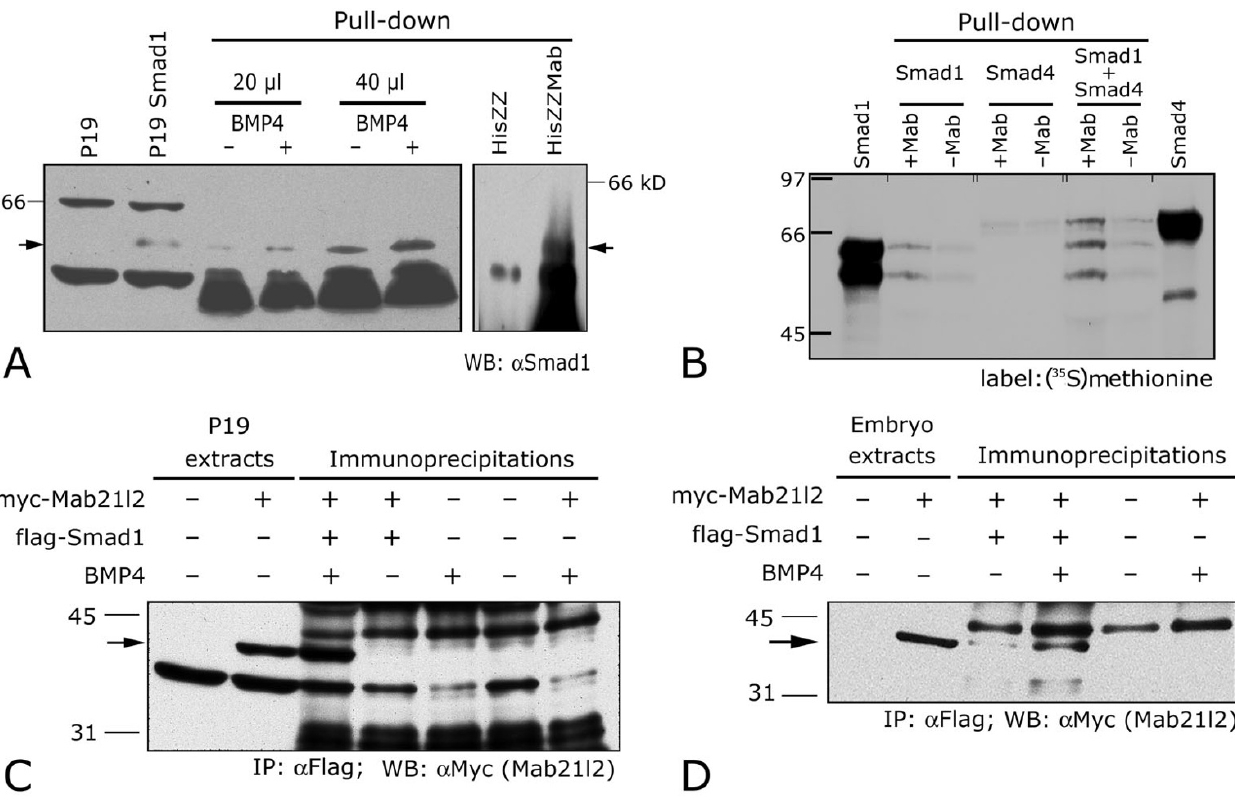
Figure 5 Mab21l2 interacts with Smad1 in vitro and in vivo. (A) Lanes 1, 2: immunoblotting of total lysates from P19 cells, mock- and Smad1 -transfected, respectively. P19 cells do not express detectable levels of endogenous SMAD1. Lanes 3–8: Affinity chromatography (pull-down) experiment. High-stringency eluates from untransfected P19 were separated by SDS-PAGE and transfered onto nitrocellulose filters. The blots were immunolabeled using an anti-SMAD1 antibody. Lanes 3–6: the in vitro interaction is not strictly dependent on activation of BMP signaling: the pull-down experiment was performed with 20 µ l (3, 4) and 40 µ l of P19 cell lysates (5, 6). Lysates came from P19 cells treated (4, 6) or untreated (3, 5) with BMP4. Lanes 7, 8: an His- ZZ-MAB21L2 protein (HisMab) synthesized in E. coli (lane 8) was coupled to a sepharose-Ig resin and incubated with cell lysates of P19 cells treated with BMP4. As a negative control, an in-vitro synthesized His-ZZ incubated with the same P19 lysates fails to pull down a 53 kD band. Arrows: SMAD1 (53 kD). (B) direct interaction between SMAD1 and MAB21L2; no direct interaction between SMAD4 and MAB21L2. An His-ZZ-MAB21L2 protein (+Mab) synthesized in E. coli (lane 2) was cou- pled to a sepharose-Ig resin and incubated with in vitro -translated SMAD1 (lanes 2), SMAD4 (lanes 4), and SMAD1 + SMAD4 (lanes 6). Negative controls were represented by His-ZZ-coupled resins (-Mab) incubated with the same in vitro -synthesized proteins (lanes 3, 5, 7). Lanes 1 and 8 contain in vitro -synthesized SMAD1 and SMAD4, respectively. (C) BMP4-dependent in vivo co-immunoprecipitation of flag-SMAD1 and myc-MAB21L2 in P19 cells. Cells were mock-transfected, transfected with flag- SMAD1 and/or with myc-MAB21L2, as indicated, and either treated with BMP4 or left untreated. In lanes 3–7, cell lysates were immunoprecipitated with a monoclonal anti-flag antibody. Cell lysates in lanes 1, 2 and immunoprecipitates in lanes 3–7 were gel fractionated and transfered to nitrocellulose filters. Blots were immunolabeled with an anti myc antibody. Arrow (42 kD) points to a band in lanes 2, 3) corresponding to myc-MAB21L2. (D) in vivo co-immunoprecipitation of flag-SMAD1 and myc- MAB21L2 in stage 11 Xenopus embryos, facilitated by BMP4 overexpression. Embryos were water-injected, injected with flag- Smad1 and/or with myc-Mab21l2 RNA, as indicated, and coinjected with BMP4 where indicated. In lanes 3–7, cell lysates were immunoprecipitated with a monoclonal anti-flag antibody. Embryo lysates in lanes 1, 2 and immunoprecipitates in lanes 3–6 were gel fractionated and transfered to nitrocellulase filters. Blots were immunolabeled with an anti myc antibody. Arrow (42 kD) points to a band in lanes 2–4) corresponding to